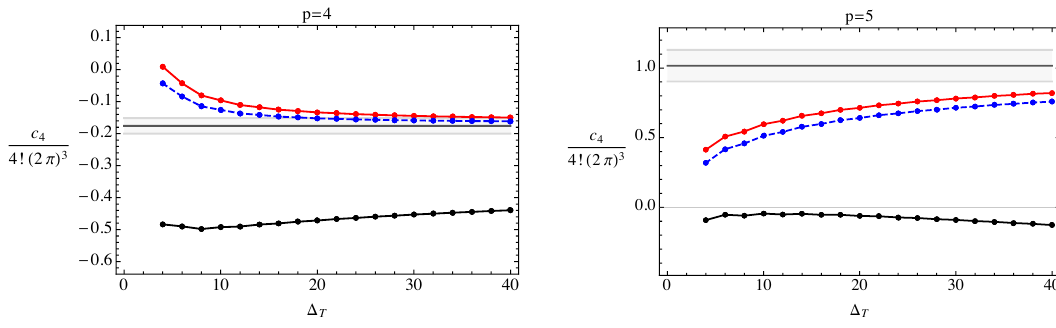
Figure 3 . Plotted in black and red are the results for the HT and alternative truncation (a.t.) regulation of the c 4 coefficients respectively. The numerical integral of the connected four-point function is shown in gray. Plotted in blue are the HT regulated calculations plus the expressions in (5.15) (left plot) and (5.16)